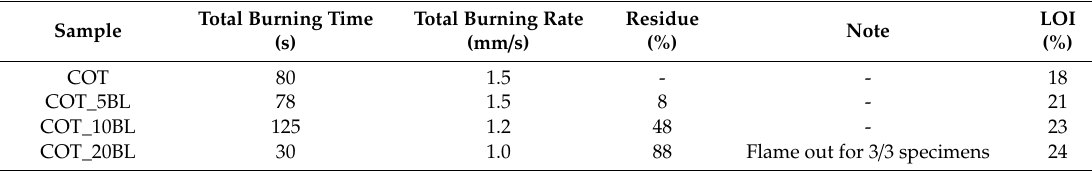
Figure 7. SEM micrographs of untreated cotton ( a ) and fabrics coated with 5 ( b ), 10 ( c ) and 20 ( d ) BL. Reproduced with permission from [49]. Copyright 2013, Elsevier. Table 11. Flammability data of untreated and LbL-treated cotton